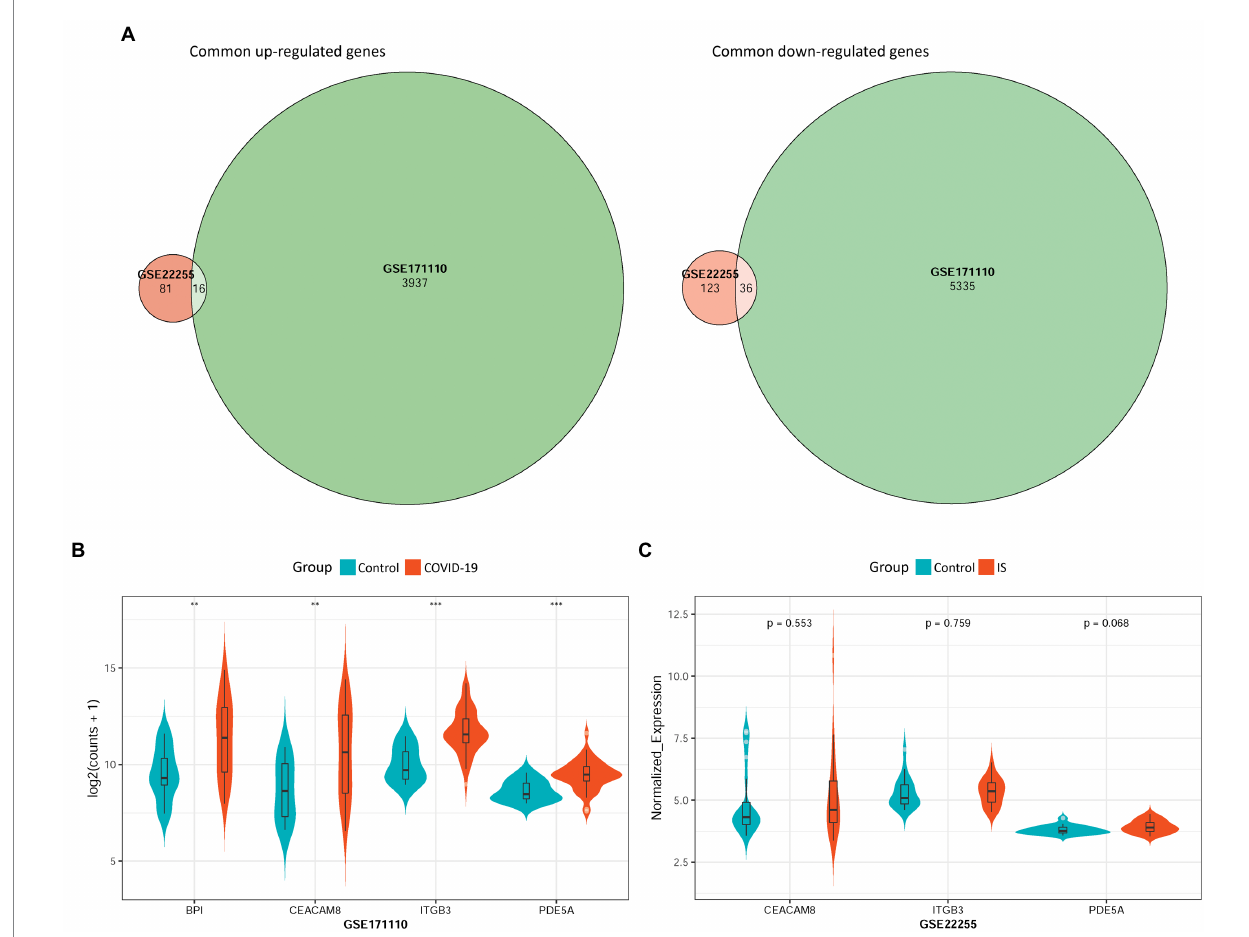
FIGURE 5 Validation of hub-shared genes in IS and COVID-19 using two external validation datasets GSE22255 and GSE171110. (A) Common DEGs with consistent changes in the expression trends in the two diseases, including 16 up-regulated genes and 36 down-regulated genes. (B) The differential expression of four hub-shared genes (PDE5A, ITGB3, CEACAM8, and BPI) in the GSE171110 dataset. (C) The differential expression of hub-shared genes in the GSE22255 dataset. IS: ischemic stroke; COVID-19: coronavirus disease